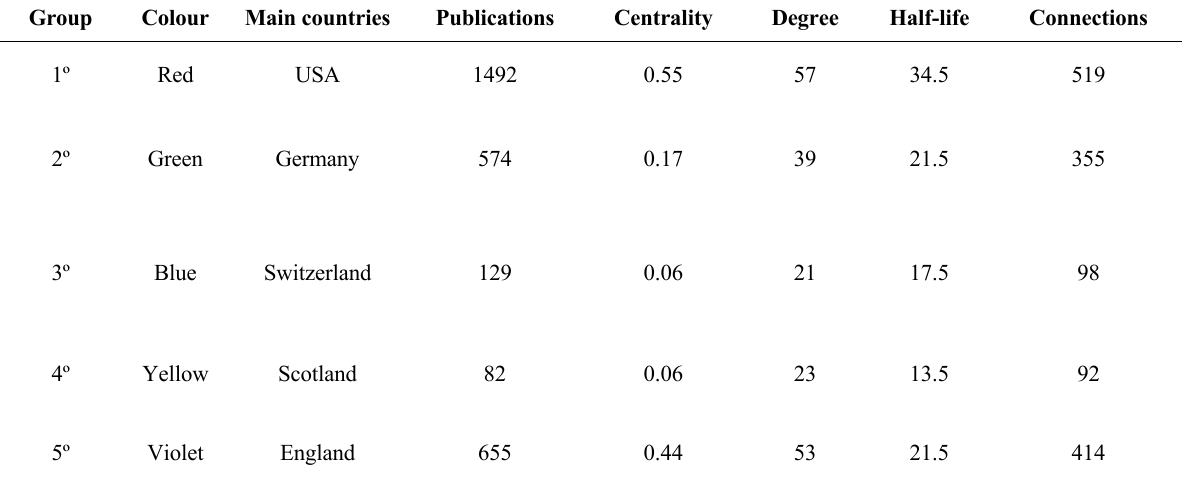
Table 2. Characteristics of the main countries